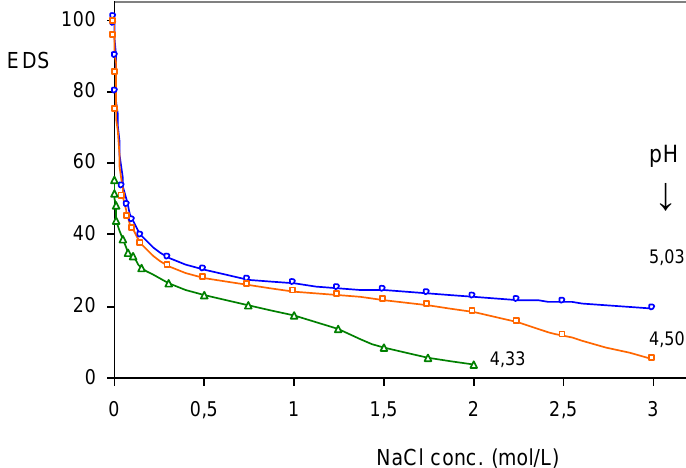
Figure 3. Equilibrium degree of swelling (EDS) in relation to the ionic strength (conc. of sodium chloride) for the hydrogel AVa-5 at different pH